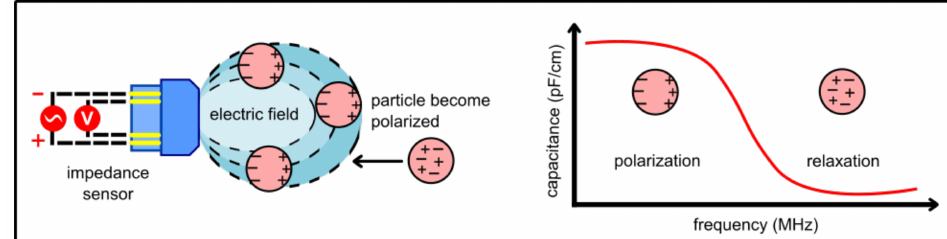
Figure 3. Dielectric spectroscopy. The sensor setup is shown on the left, and the dispersion (dielectric polarization and relaxation of particles) is shown on the